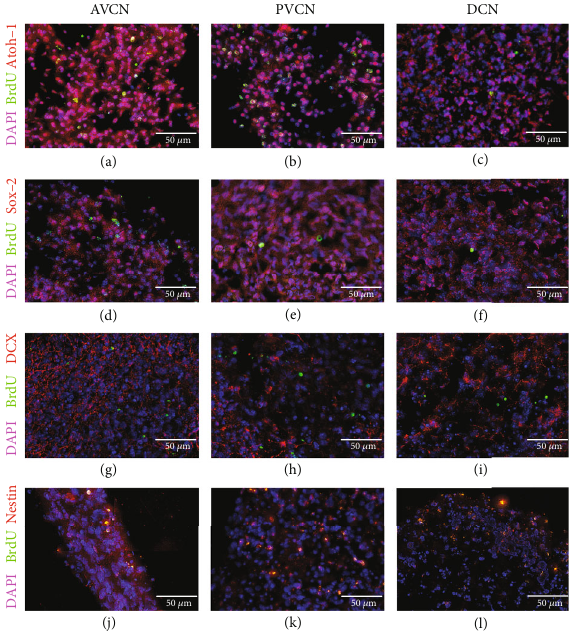
Figure 5: Neurogenesis in the CN subnuclei. Preparations from PND 9 animals were incubated as whole-mount organ cultures for 48h in stem cell medium and the S phase marker BrdU. The immunohistological analysis showed the expression of neural stem cell markers and mitotic activity of individual cells. The transcription factors Atoh-1 and Sox-2 as well as the neural stem cell markers DCX and nestin were detected in preparations from all subnuclei. All whole-mount organ cultures showed a BrdU uptake of individual cells after an incubation period of 48 h. Cell nuclei were stained with